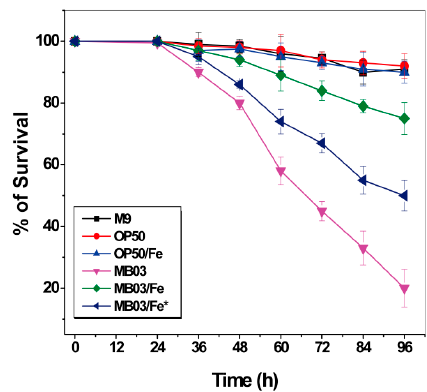
Figure 7. E ff ect of additional accessible iron on the nematocidal activity of P. syringae MB03 against C. elegans : Survival of worms when exposed to M9, OP50 (OP50 was grown in M9), OP50 / Fe (OP50 was grown in M9 with 100 µ mol L − 1 iron), MB03 (MB03 was grown in M9), MB03 / Fe (MB03 was grown in M9 with 100 µ mol L − 1 iron), and MB03 / Fe* (the filtrate generated from 48 h MB03 culture in M9 and then incubated with 100 µ mol L − 1 iron overnight) filtrates in LK assay. M9 and OP50 was used as control. MB03 filtrate showed significant killing that was attenuated by addition of exogenous iron while growth of MB03 in M9 or by overnight incubation of MB03 filtrate was attenuated with 100 µ mol L − 1 iron. The mortality of worms in each well was determined in every 12 h. Three biological replicates were used, and 40–50 worms were added per replicate. Error bars represent the standard deviations from the means of three independent